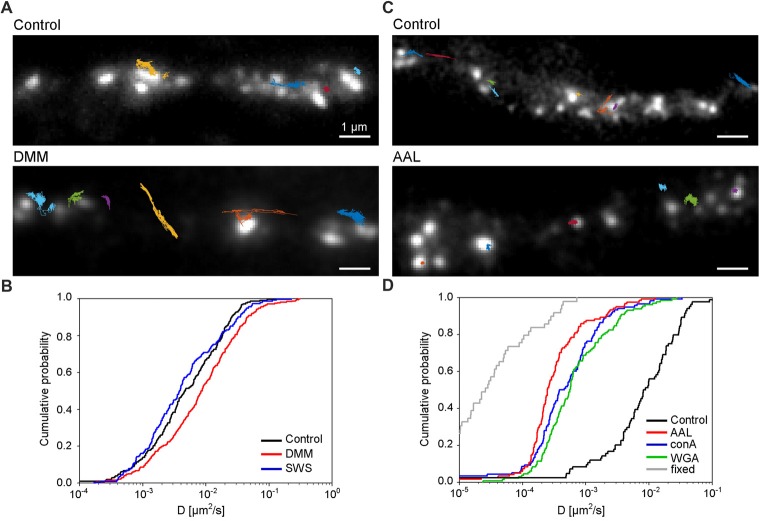
N-glycosylation regulates the mobility of GluN3A-containing NMDARs at the cell surface of hippocampal neurons. (A,C) Representative trajectories of quantum dot (QD)-labeled GFP-GluN3A (GluN3A) subunits in hippocampal neurons treated with 200 μg/ml DMM (A) or with the lectin AAL (20 μg/ml) (C). (B,D) Comparison of the cumulative distribution of the diffusion coefficients measured for QD-labeled GluN3A subunits in hippocampal neurons treated for two days with 200 μg/ml DMM, 100 μg/ml swainsonine (n = 208–314 trajectories per condition; B), or incubated after QD labeling with 20 μg/ml of AAL, conA, or WGA (n = 84–131 trajectories per condition; D). The diffusion coefficients in fixed cells (shown in D) were obtained from an independent experiment (n = 49 trajectories). Pairwise comparisons of the distributions show the following statistically significant differences: DMM vs. control (p < 0.003), AAL, conA, WGA vs. control (p < 10−23), AAL, conA, WGA vs. fixed (p < 10-13). The largest p-value obtained in Kolmogorov-Smirnov test and Mann-Whitney-Wilcoxon test is stated.